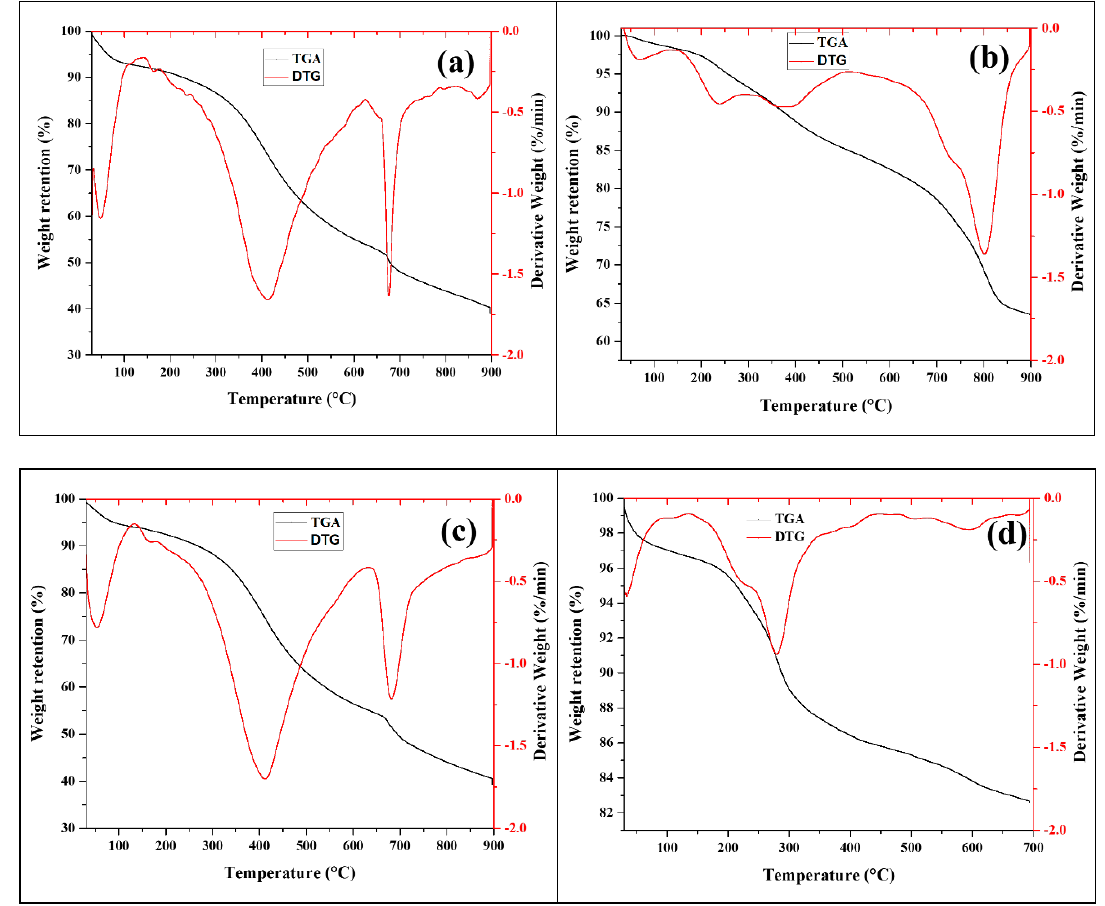
Figure 3. TGA/DTG curves for ( a ) Fe 3 O 4 @C-T 190 t 3 ; ( b ) Fe 3 O 4 @C-T 190 t 4 ; ( c ) Fe 3 O 4 @C-T 190 t 5 ; ( d ) Fe 3 O 4 NPs.